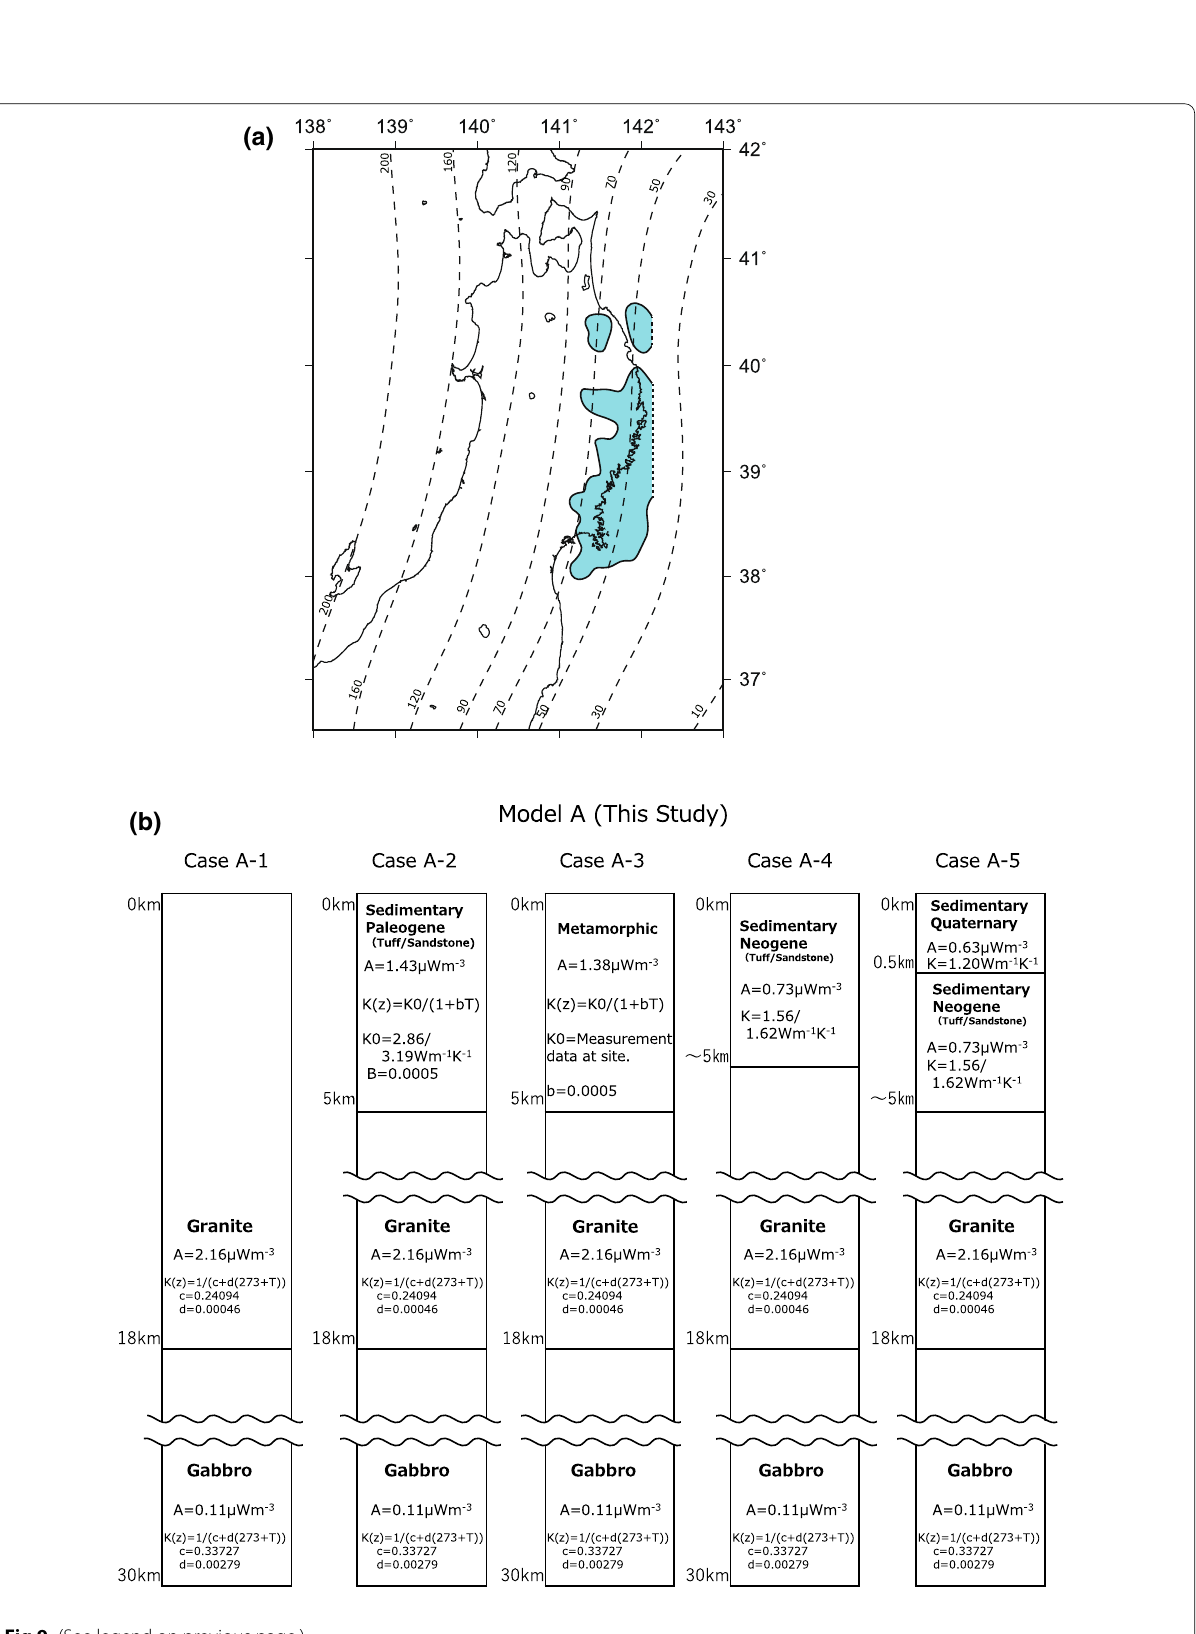
Fig.9 (See legend on previous